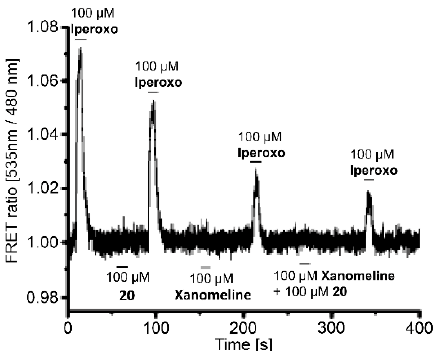
Figure 6. Fragment-based analysis to evaluate the contributions of the single molecular moieties, dihydroquinolinone ( 20 ), and Xanomeline ( 10 ), of the Xanomeline/77-LH-28-1 hybrids to the M 1 FRET signal. A single-cell FRET recording of the M 1 receptor sensor stably expressed in HEK293 cells is shown. One hundred micromolar Iperoxos were used as a reference ligand throughout the recording, as indicated by black bars above the recorded signal. One hundred micromolars of 20 and 10 were applied separately or together at the appropriate time points, as indicated by black bars below the recorded signal.